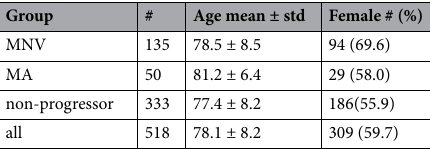
Table 1. Patient characteristics.